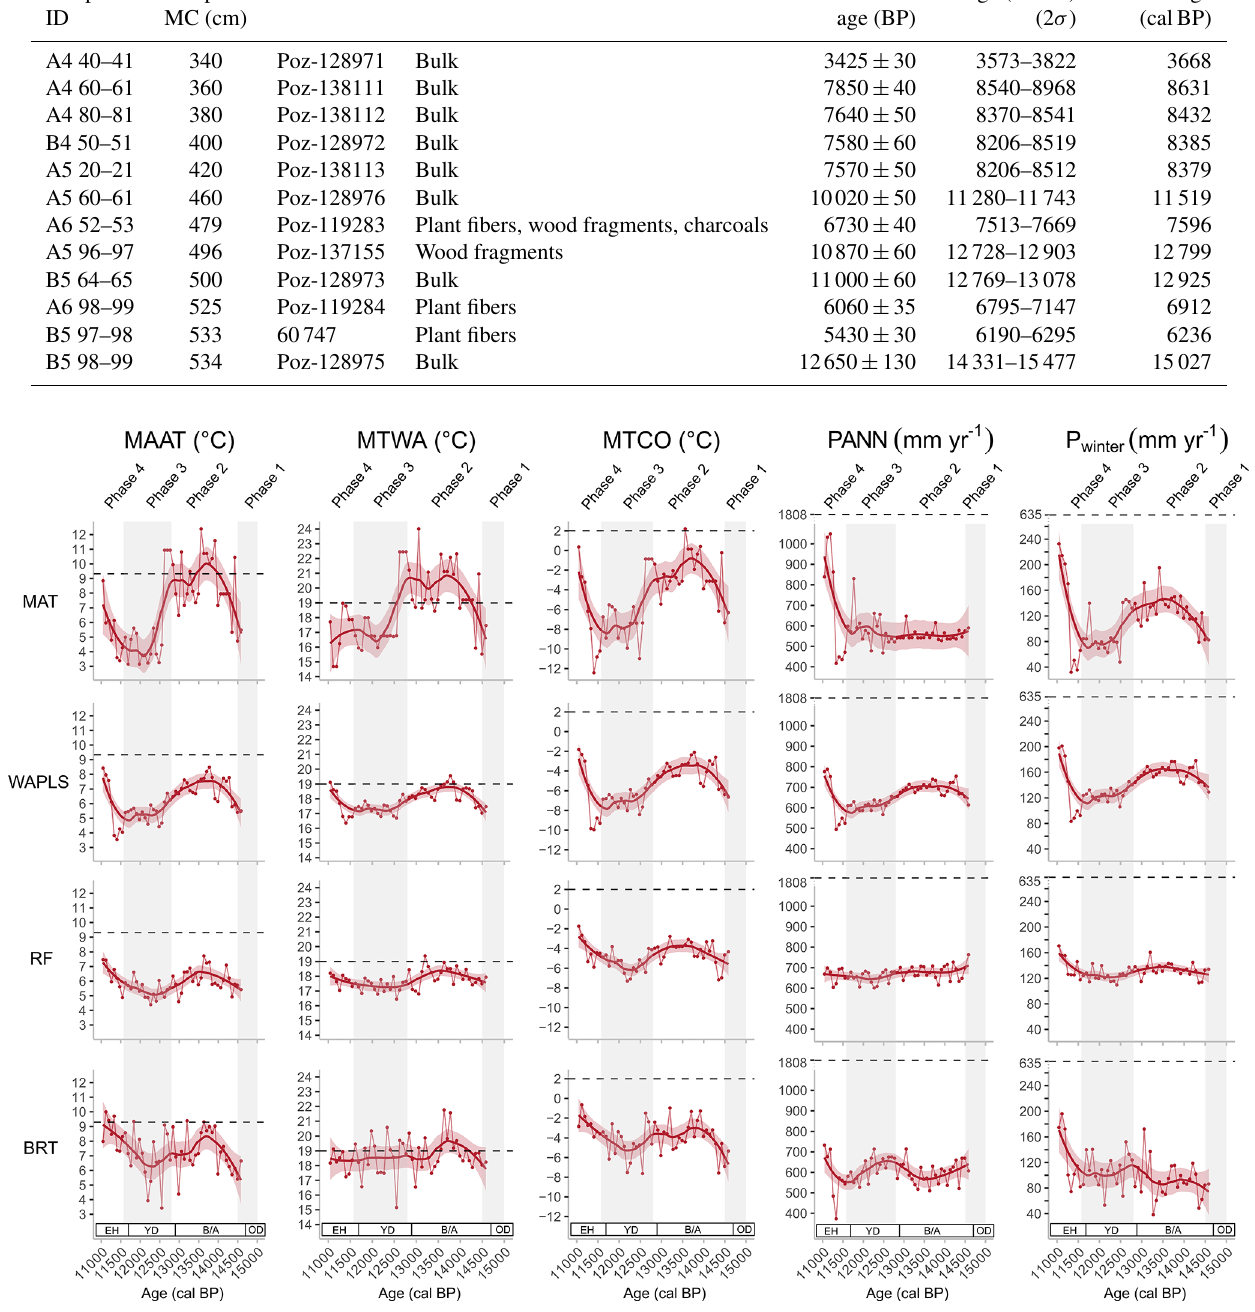
Figure 5. Lake Matese pollen-inferred climate reconstruction based on four methods of measuring against age: MAT (modern analogue technique), WAPLS (weighted averaging partial least-squares regression), RF (random forest) and BRT (boosted regression trees). Large lines correspond to LOESS smoothed curves, shaded areas correspond to the 95% confidence interval and dashed lines correspond to modern climate values of Lake Matese. MAAT stands for mean annual air temperature. MTWA stands for mean temperature of the warmest month. MTCO stands for mean temperature of the coldest month. PANN stands for mean annual precipitation. P winter indicates winter precipitation. OD stands for Oldest Dryas. B/A stands for Bølling–Allerød. YD stands for Younger Dryas. EH stands for early